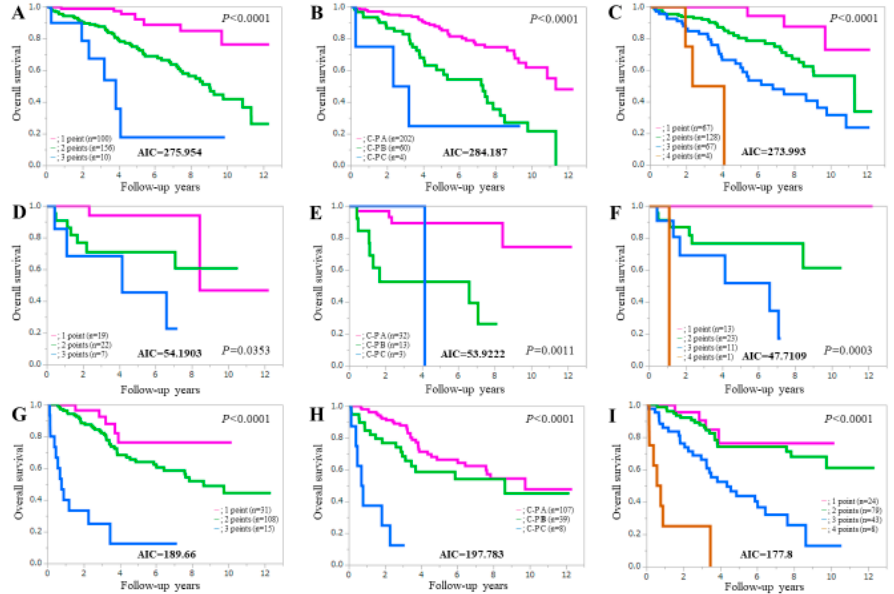
Figure 6. Kaplan-Meier curves in patients with HCV ( n = 266) according to ALBI grade ( A ), the Child- Pugh classification ( B ) and ALBI-SMM grade ( C ), and Kaplan-Meier curves in patients with HBV ( n = 48) according to the ALBI grade ( D ), the Child-Pugh classification ( E ) and the ALBI-SMM grade ( F ), and Kaplan-Meier curves in patients with other liver disease etiologies ( n = 154) according to ALBI grade ( G ), the Child-Pugh classification ( H ) and ALBI-SMM grade ( I ).